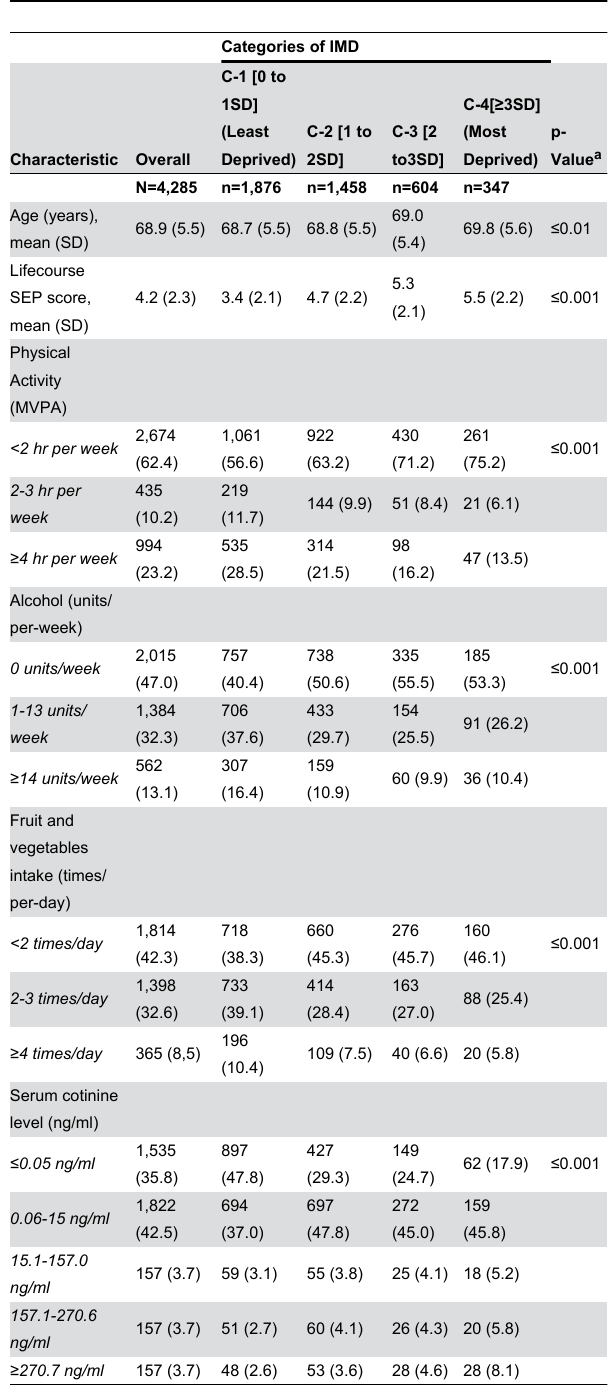
Table 1. Sociodemographic factors and health-related behaviours across categories of the